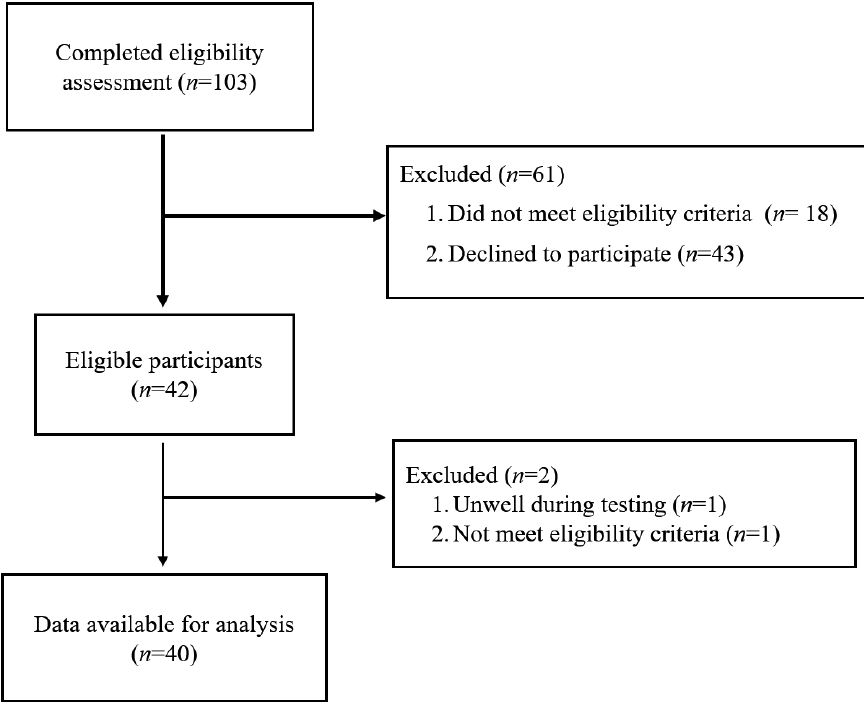
Figure 1. Flow diagram.